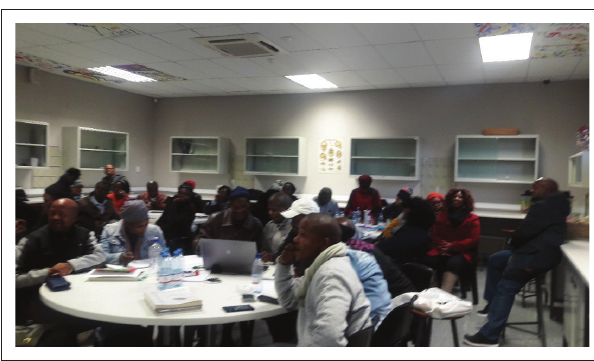
FIGURE 3: Peer collaboration during the